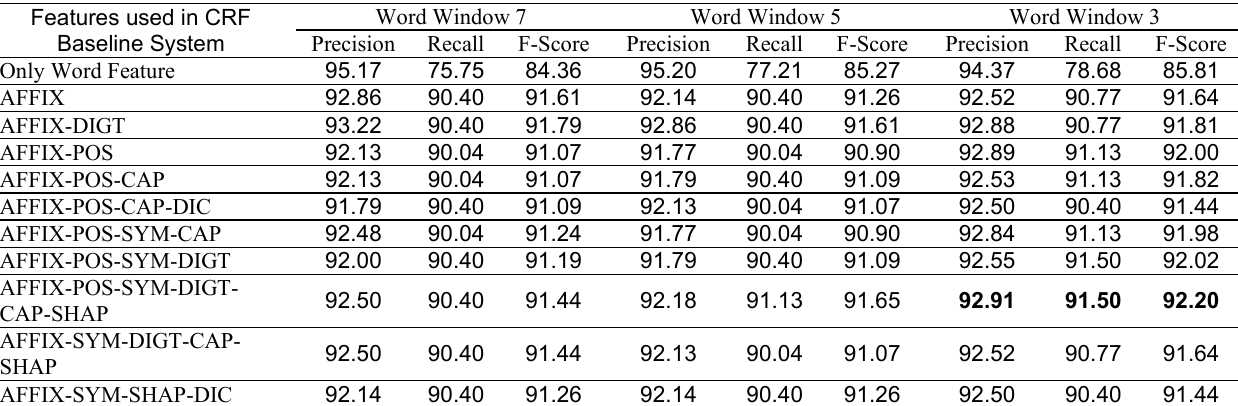
Table 1. Result of Baseline CRF Based NER System on Dataset